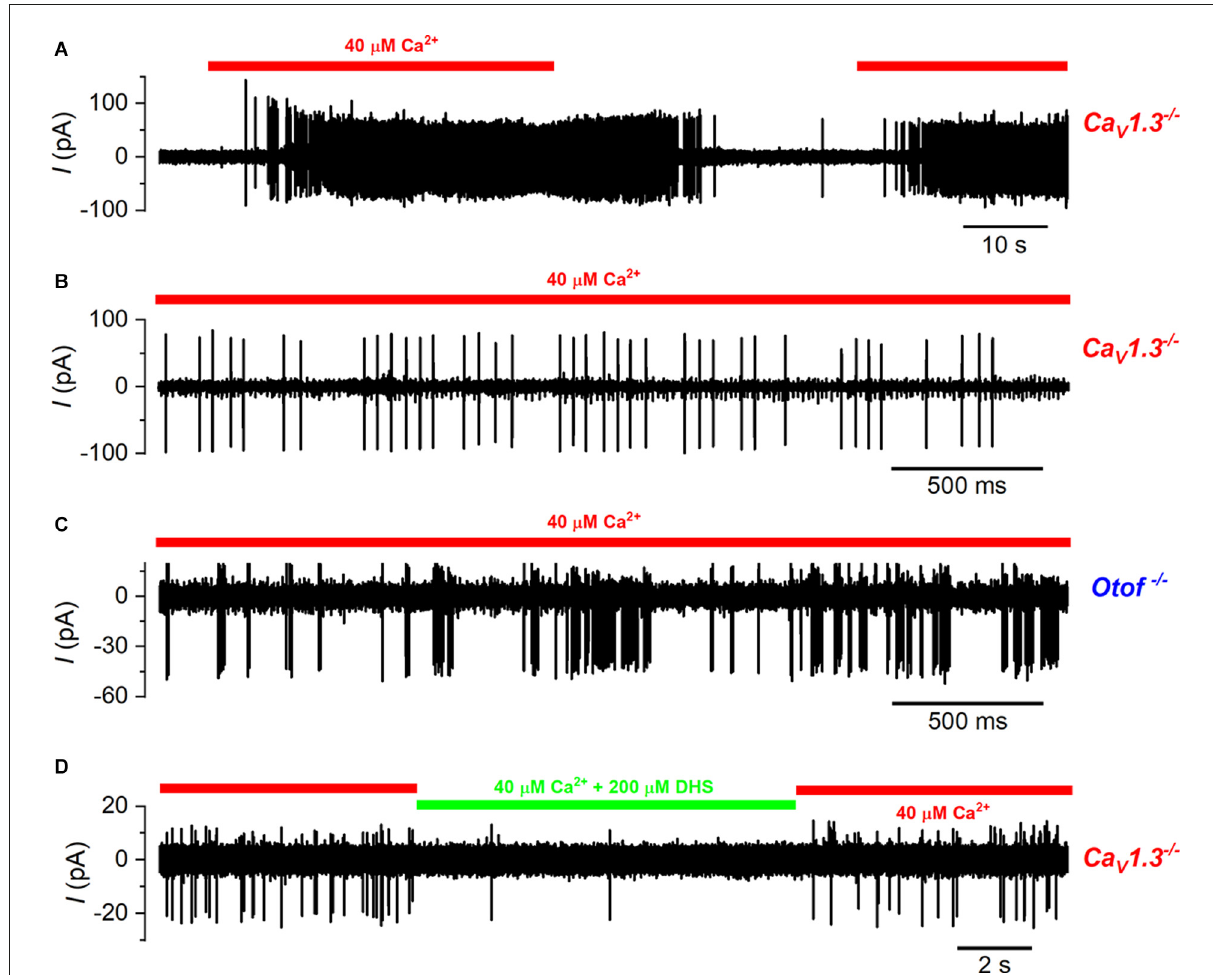
FIGURE7 Calyx spiking activity is elicited by type-I hair cell depolarization in Ca V 1.3 − / − and otoferlin − / − mice. (A) A typical example of a cell-attached recording from a calyx of a Ca V 1.3 − / − mouse. As for wild-type cells, spikes were elicited by the repeated local perfusion of 40 µ M Ca 2+ (indicated by the red bar) instead of normal extracellular solution that contained 1.3 mM Ca 2+ . (B) Expanded view of the spiking activity in the presence of 40 µ M Ca 2+ from panel (A) . Note that in this calyx there were large spikes and small spikes that were of a higher frequency and likely due to the branching of this fiber to contact another type-I hair cell. (C) Action potentials in the calyx during the perfusion of 40 µ M Ca 2+ in an Otof -/ - mouse. (D) Calyx spiking activity triggered by 40 µ M Ca 2+ in Ca V 1.3 − / − mice is reversibly suppressed by the additional perfusion of the MET channel blocker DHS (200 µ M; indicated by the green